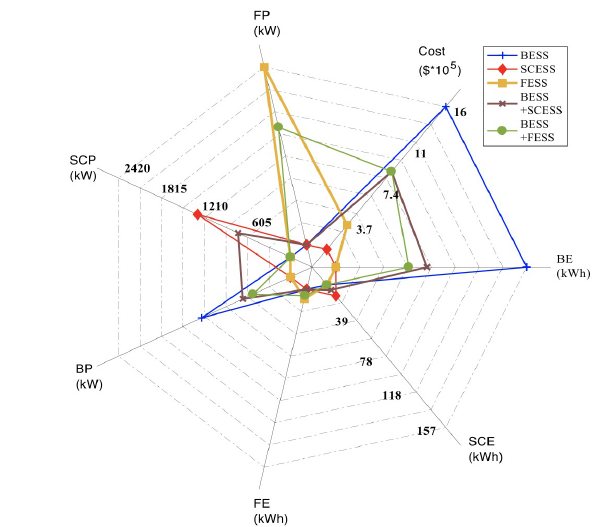
Figure 10. Comparison of different combinations of ESS for 35% regenerative energy saving, where BE: Battery Energy, BP: Battery Power, SCE: SC Energy, SCP: SC Power, FE: Flywheel Energy, FP: Flywheel Power. The axes for energy are scaled from 0–157 kWh, those for power are scaled from 0–2420 kW, and the axis for cost is scaled from $1.3 × 10 5 –16 × 10 5